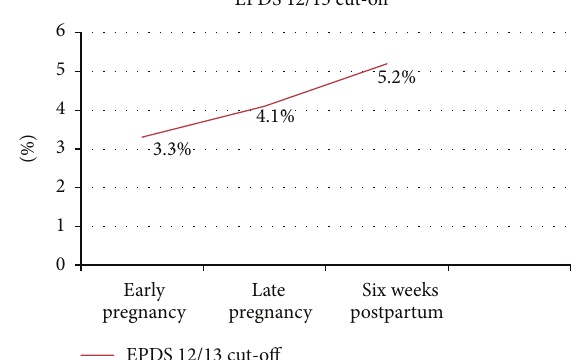
Figure 1: Prevalence rate of paternal depression from early preg- nancy to six weeks postpartum using EPDS Scale (Recommended cut-off of ≥